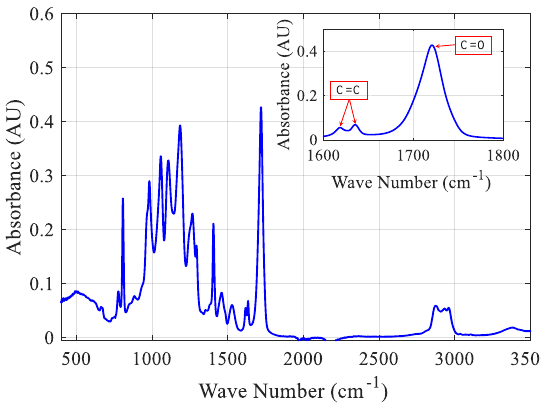
Figure 6. FTIR peaks considered in calculating the degree of monomer conversion.